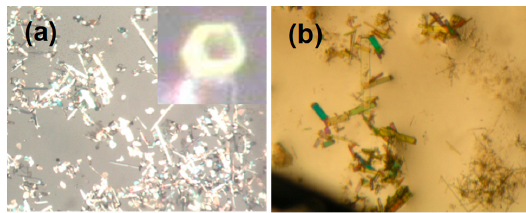
Figure 13. Optical microscope images (90× magnification) of the cisplatin crystals grown at the gel ‐ sol interface using the o ‐ xylene gel of 47 : ( a ) DMF solvate of cisplatin (Inset: magnified photo of the crystal with novel morphology), and ( b ) DMA solvate of cisplatin. Reproduced with permission from Reference [93].